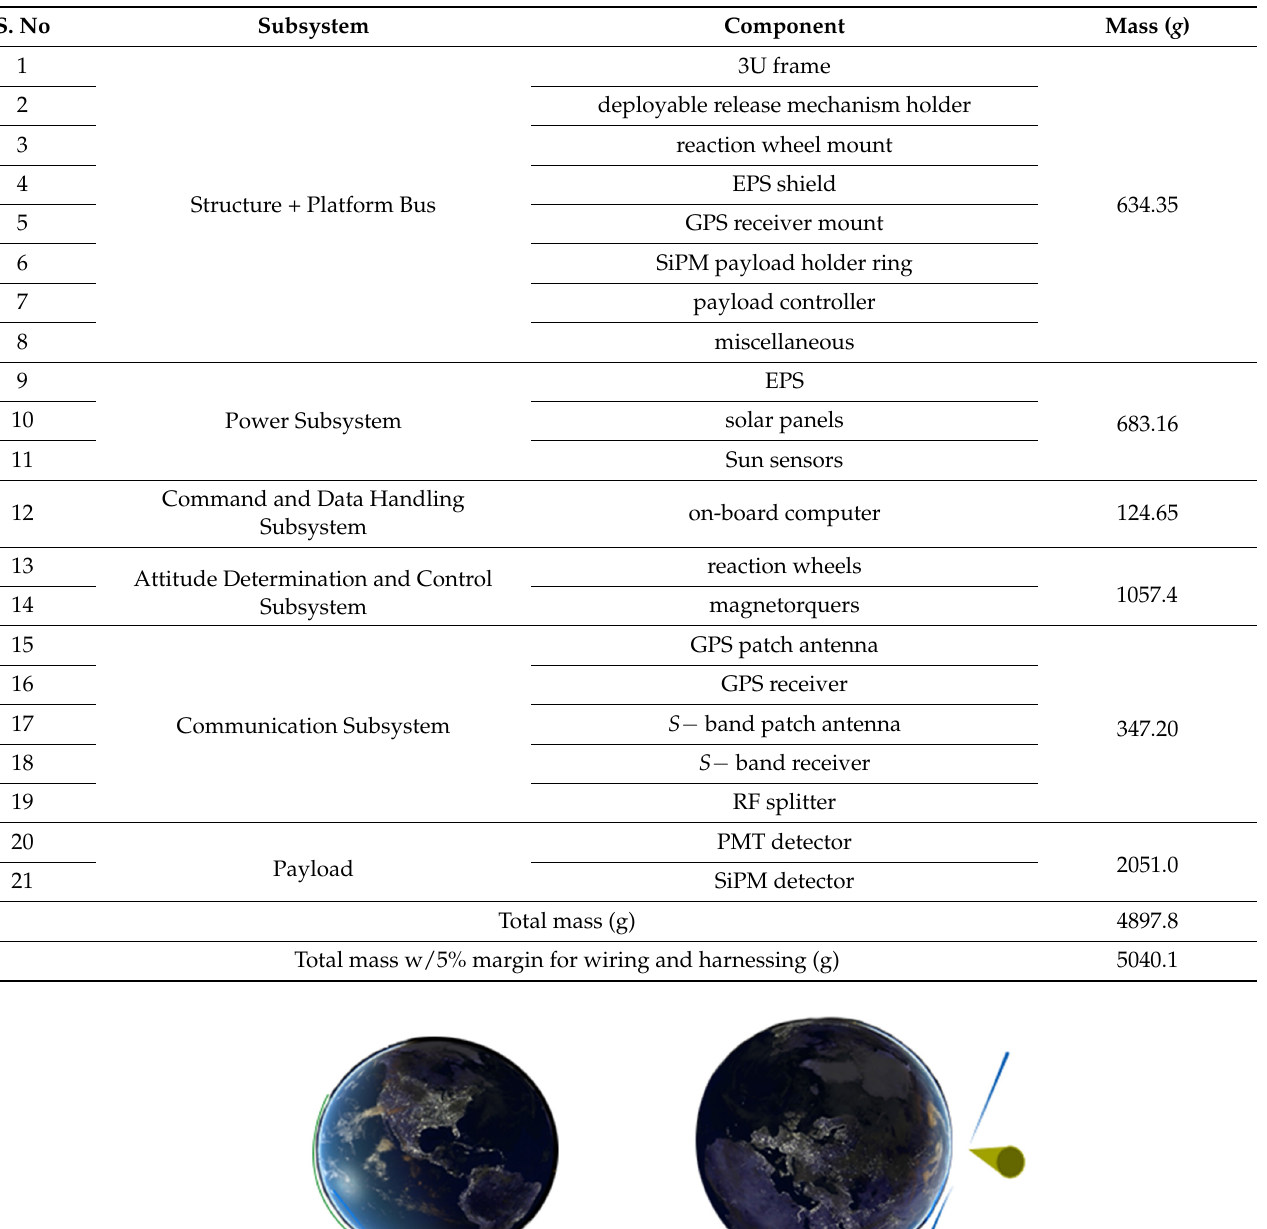
Table 2. Light-1 mass breakdown.